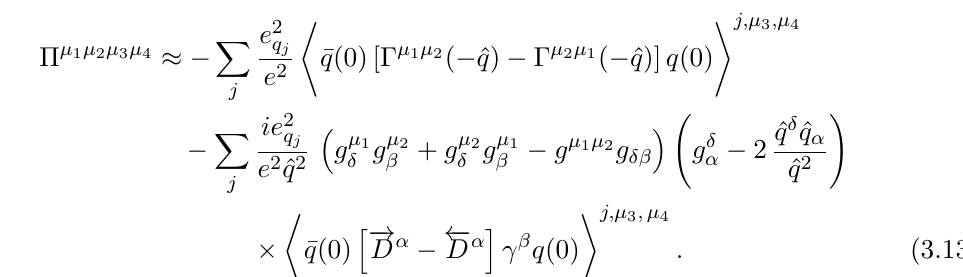
Figure 2 . The diagrams needed for the lowest order in α s OPE. The diagram with q 1 and q 2 interchanged must be